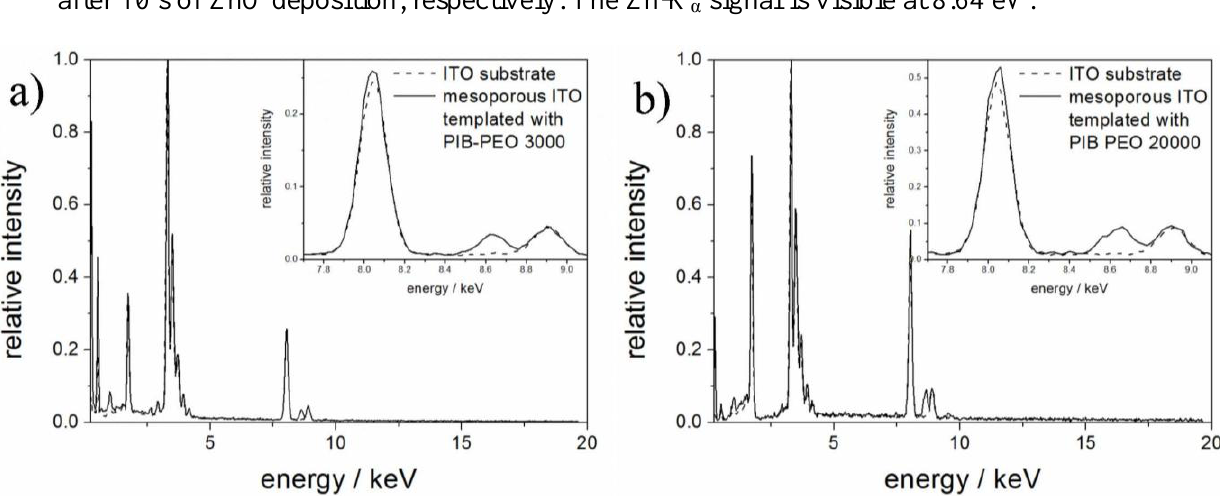
Figure 5. Comparison of the EDX spectra extracted of compact ITO layer and the mesoporous part of the ITO film prepared with PIB-PEO 3000 ( a ) and PIB-PEO 20000 ( b ) after 10 s of ZnO deposition, respectively. The Zn-K signal is visible at 8.64 α